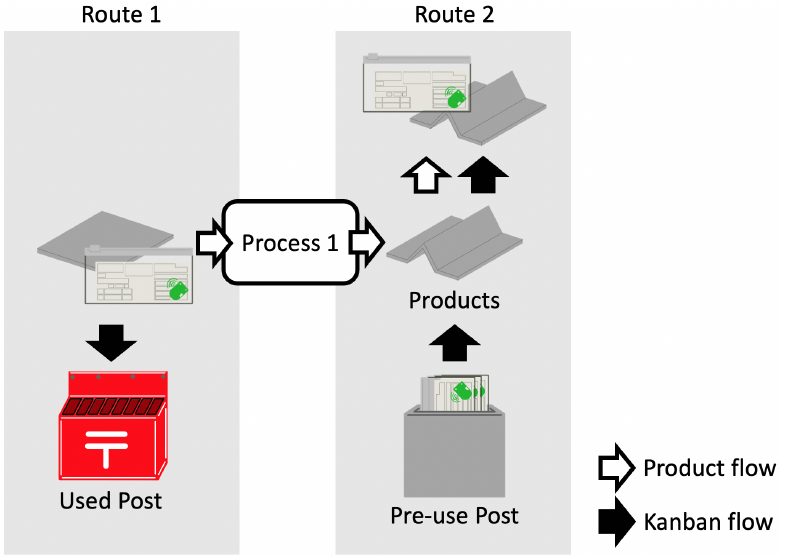
Figure 4. Detail of just before and after process 1.